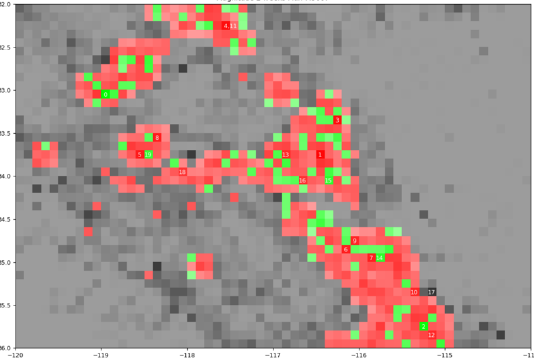
Figure 6. The 500 spatial regions (pixels) used in the analysis are divided randomly into 400 red training and 100 green validation/testing pixels with the remaining 1900 regions in shades of